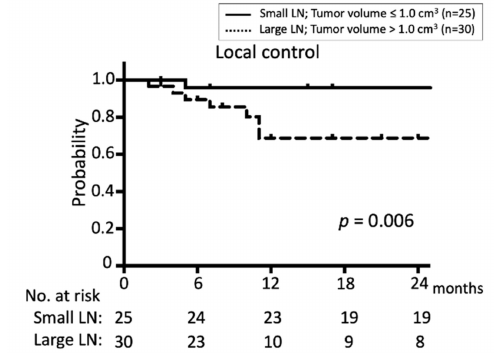
Figure 1. Kaplan–Meier survival estimates for ( a ) local control ( n = 55) and ( b ) overall survival ( n = 16) for CyberKnife-treated in-field neck lymph node (LN) lesions recurring after radiotherapy.